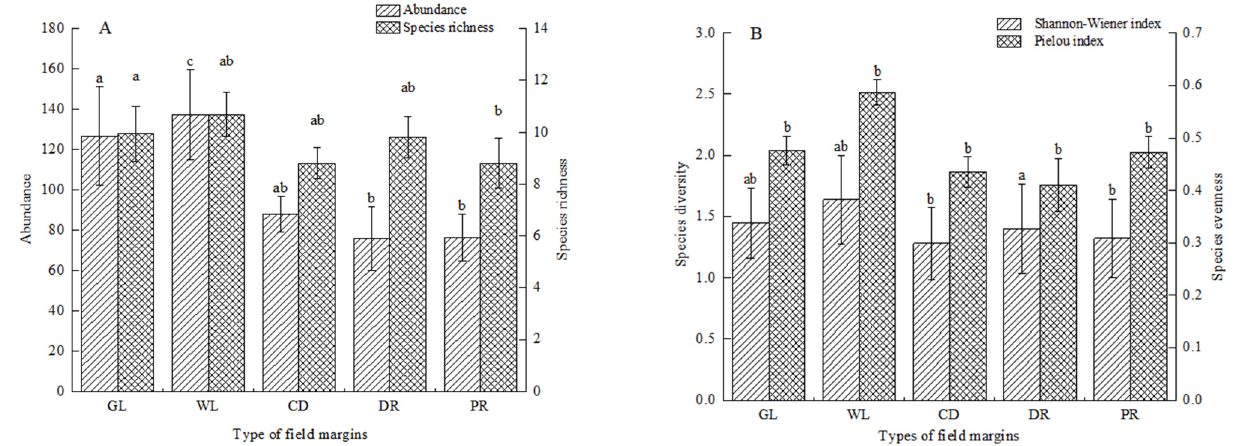
Figure 4. The abundance ( A ), species richness ( A ), species diversity ( B ), and evenness ( B ) of epigeic arthropods within arable land with different types of field margin. Different lowercase letters indicate significant differences among treatments at the p < 0.05 level. GL, WL, CD, DR, and PR represent grassland, woodland, irrigation canals and ditches, dirt roads, and paved roads.